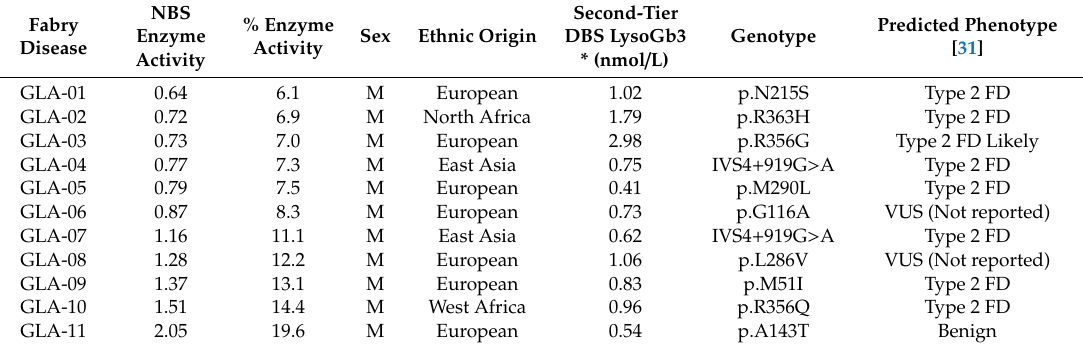
Table 5. NBS enzyme activity, confirmatory testing results and final diagnosis in newborns with suspicion of Fabry Disease. Newborns were ordered based on neonatal screening enzyme activity. NBS Fabry Disease